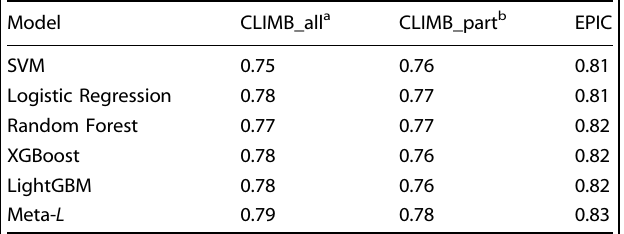
a Models trained using complete CLIMB data. b Models trained using overlapping features of CLIMB and EPIC datasets, and annual